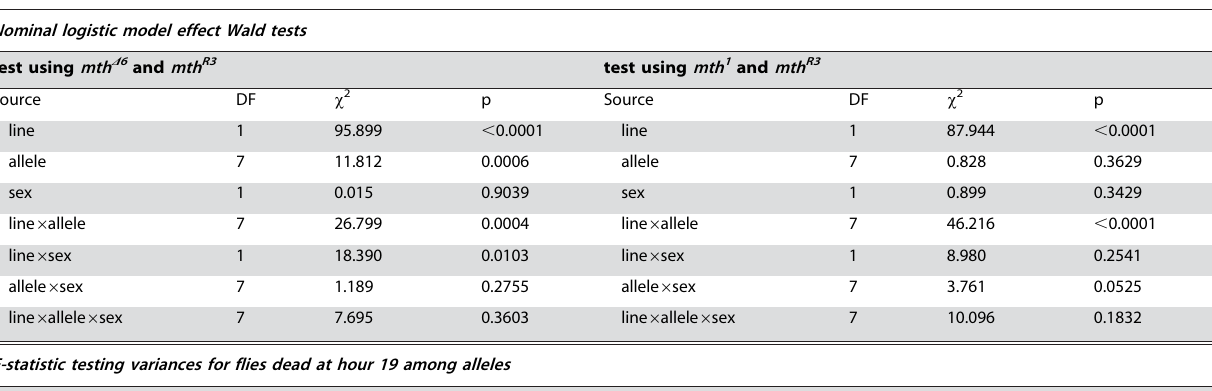
Table 3. Statistical results for the oxidative stress resistance